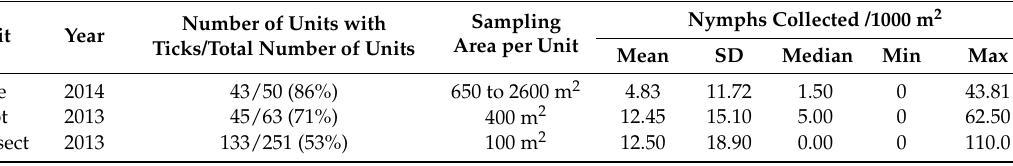
Table 2. Tick collection at site, plot, and transect scales.